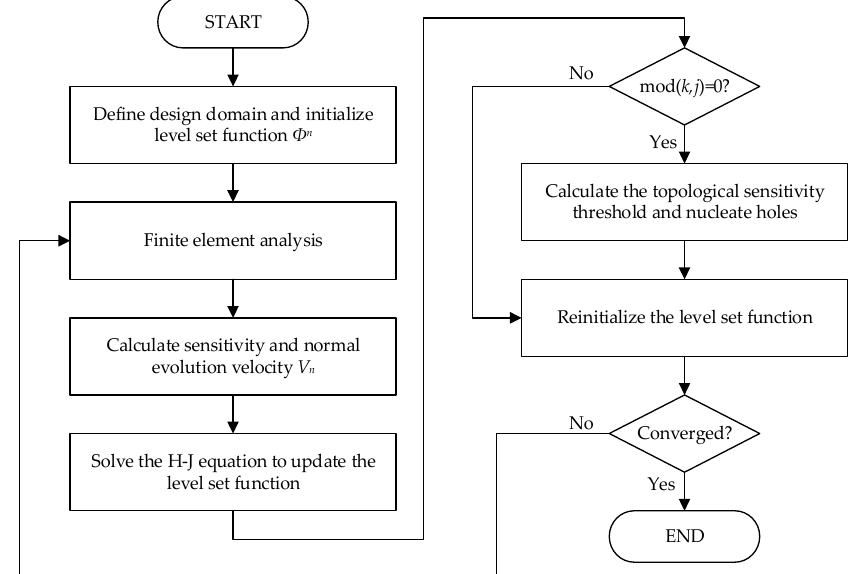
Figure 14. Flowchart of the combining BESO and topological sensitivity (CBT) level set topology optimization.